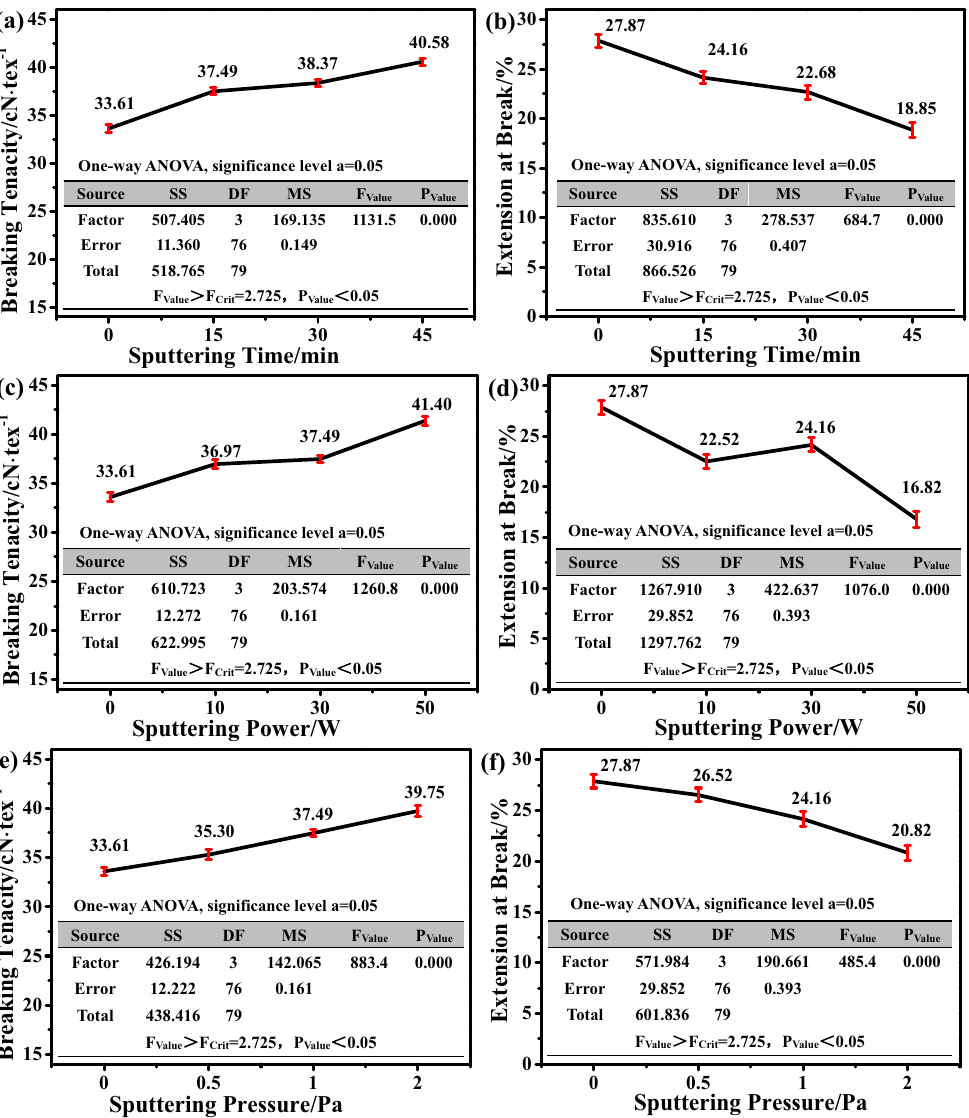
Figure 5: E ff ects of technological parameters: ( a and b ) sputtering time, ( c and d ) sputtering power, and ( e and f ) sputtering pressure on the tensile properties of PP fi